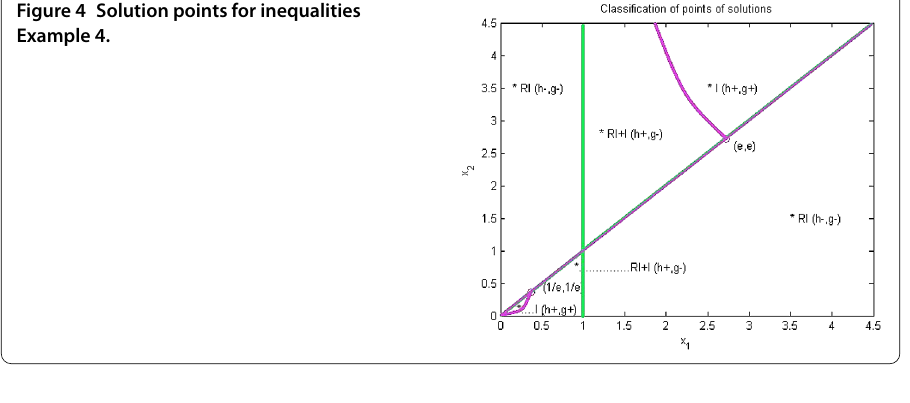
Figure 5 Solution points for inequalities Example